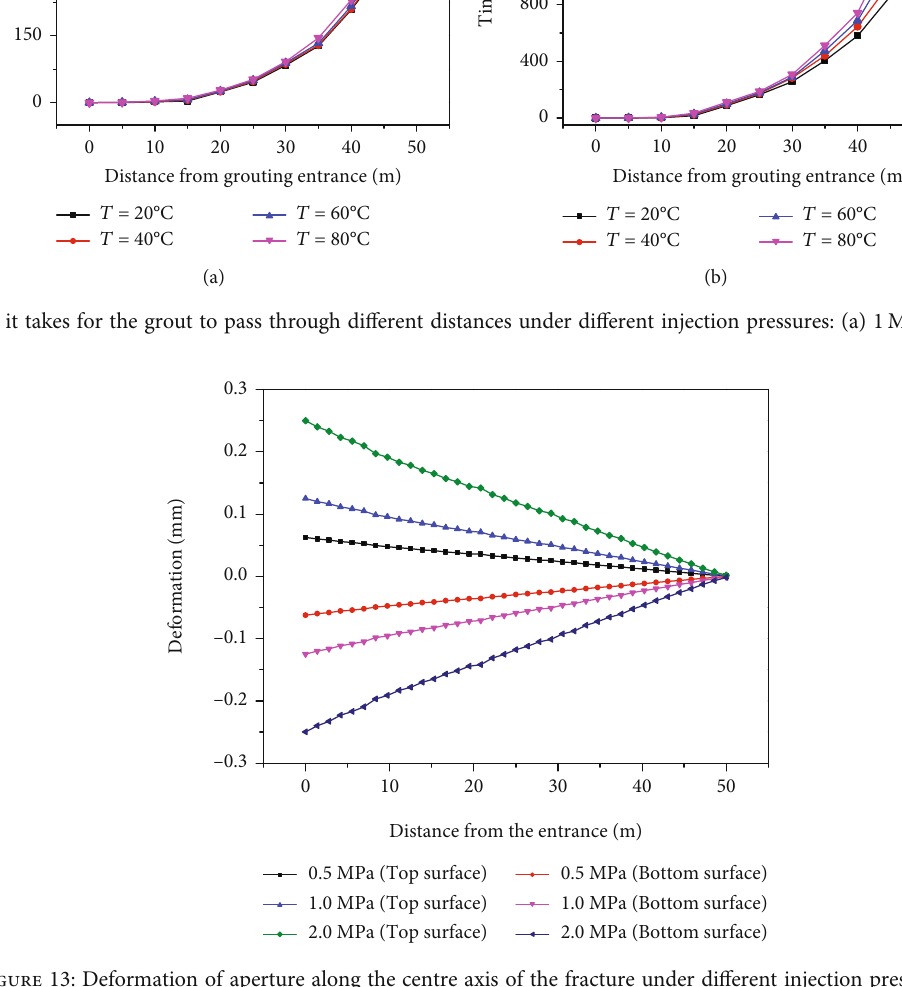
Figure 13: Deformation of aperture along the centre axis of the fracture under di ff erent injection pressures.